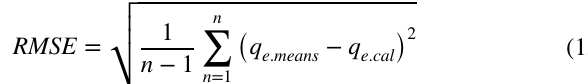
Table 2 compiles the determined parameters obtained